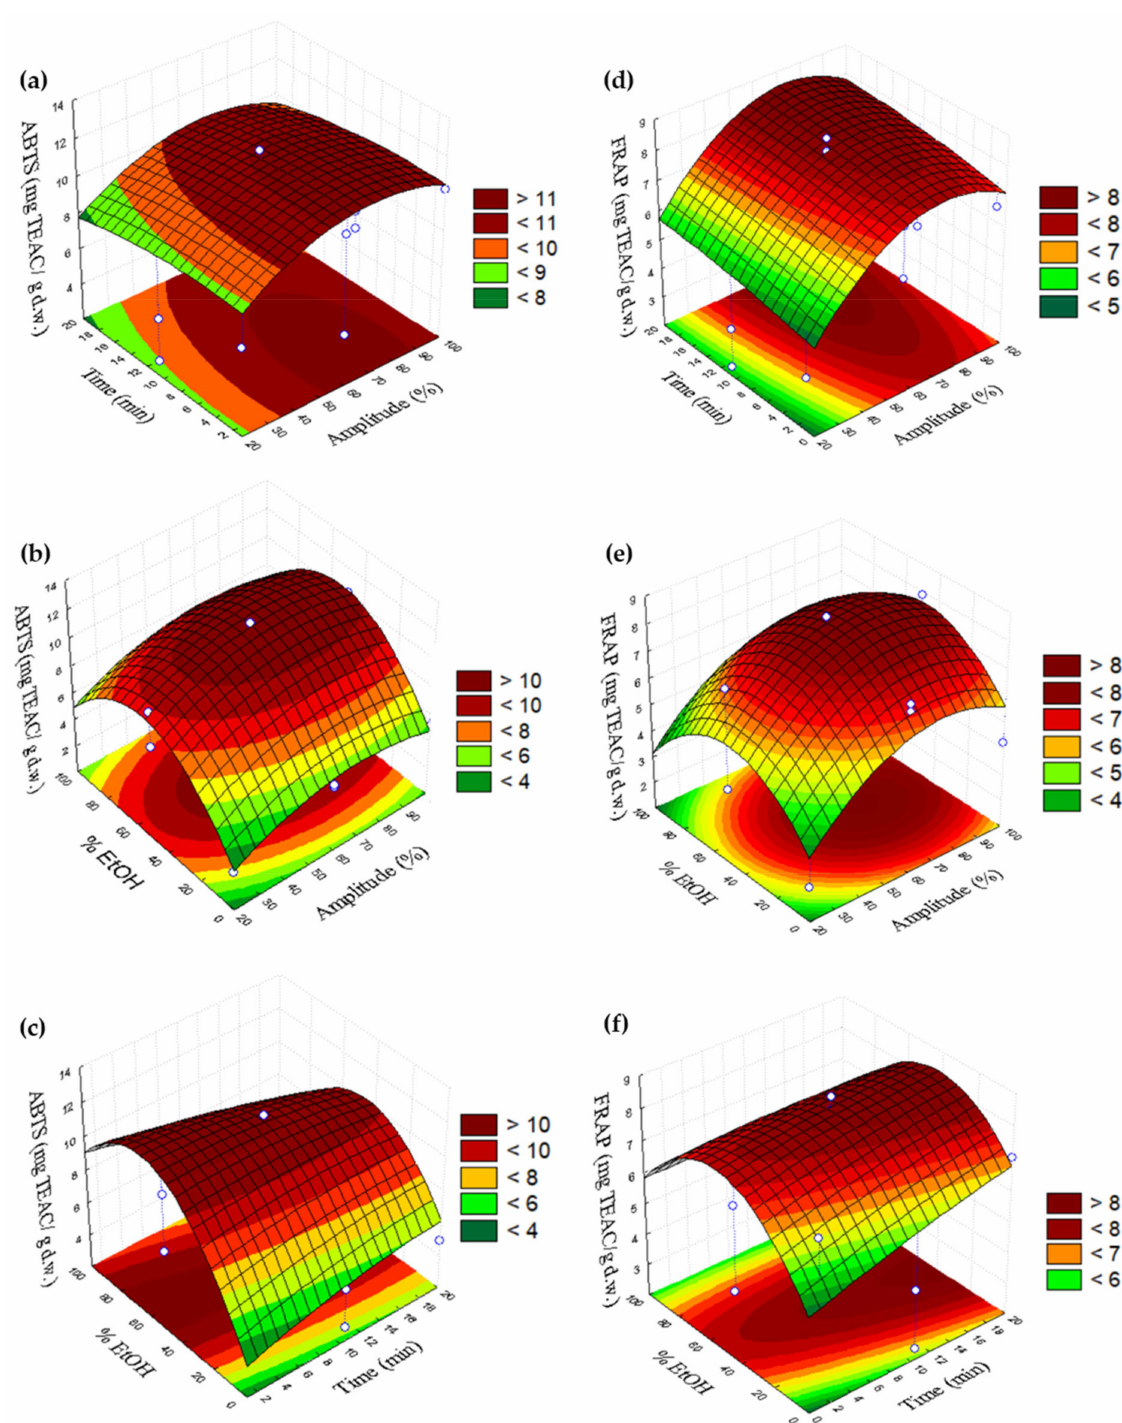
Figure 2. Three-dimensional plots showing the effects of % amplitude ( v / v ) (X 1 ) with time (X 2 ) ( a , d ), % amplitude (X 1 ) with % EtOH (X 3 ) ( b , e ) and time (X 2 ) with % EtOH (X 3 ) ( c , f ) on the ABTS and FRAP. According to the surface response plots obtained for the content of the sum of phenolic compounds, its highest content was obtained at the following conditions: 60–80% amplitude and 8–20 min (Figure 1a), 20–50% EtOH and 50–80% amplitude (Figure 1b) and 30–60% EtOH and 4–20 min. In the case of antioxidant activities by different assays, the maximum antioxidant activity by DPPH was observed in the range of 8–20 min and 60–90% of amplitude (Figure 1d), 40–70% EtOH and 40–90% amplitude in Figure 1e and 40–60%